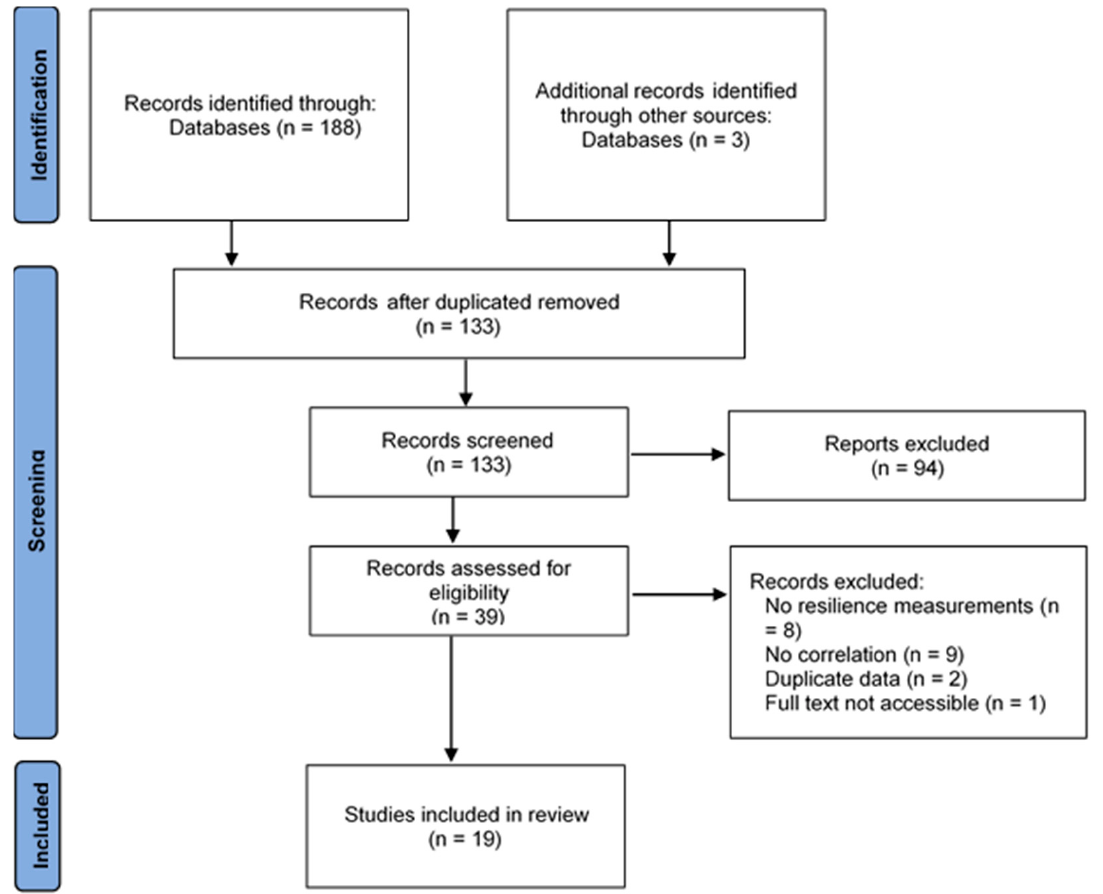
Figure 1. PRISMA diagram of the search and selection process.